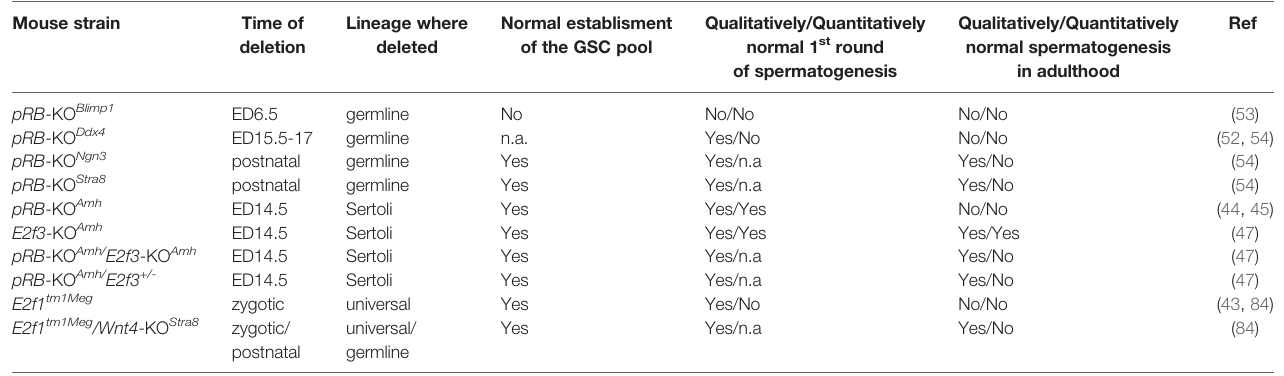
TABLE 1 | Summary of spermatogenic phenotypes in different mouse strains with a deletion in gene(s) encoding RB-E2F pathway proteins. Mouse strain Time of deletion